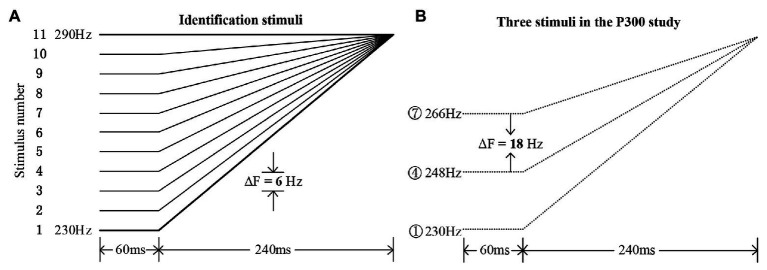
Experimental materials. (A) The 11 identification stimuli along a tone continuum ranging from typical Mandarin Tone 2 (stimulus #1) to Tone 1 (stimulus #11), with a step size of 6 Hz. (B) The three chosen stimuli in the rising set for the current P300 study (stimuli #1, #4, and #7), with an onset pitch difference of 18 Hz.